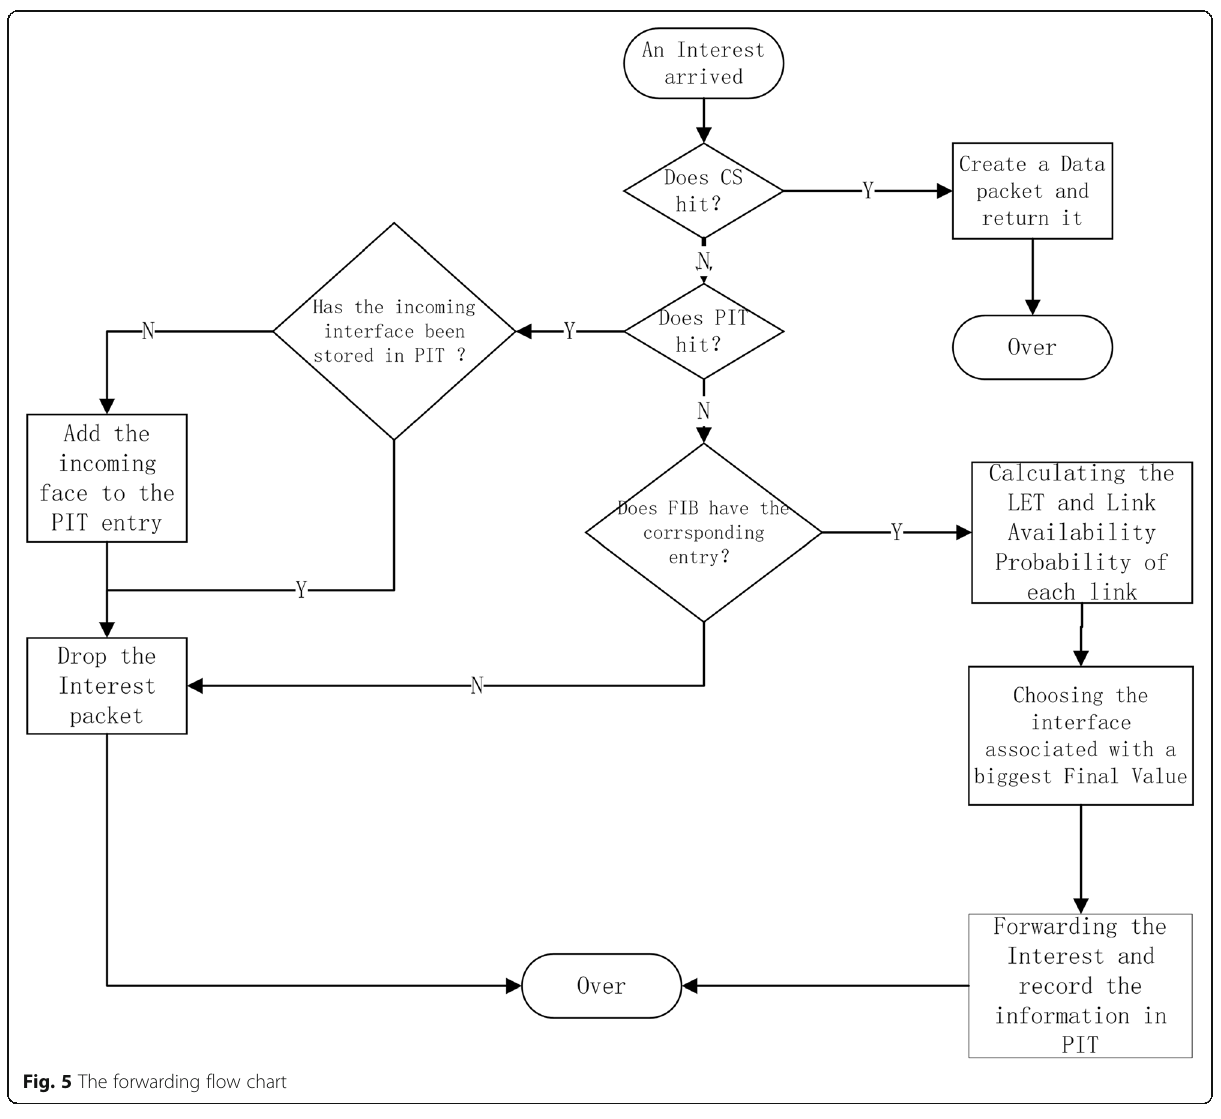
Fig. 5 The forwarding flow chart